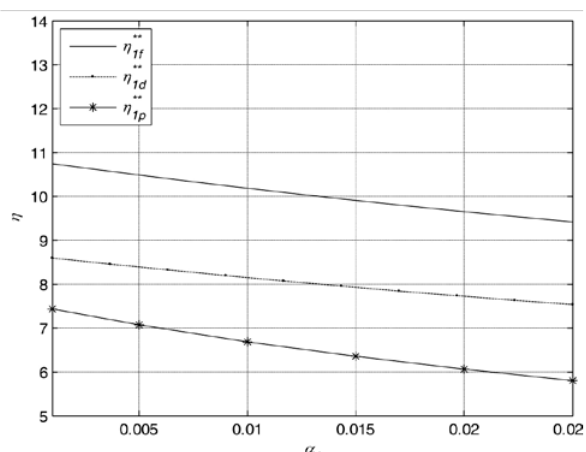
α on investment thresholds of agent 1 fig. 1. Impacts of 1 note: all the parameter values are set as follows: r = 0.05, I = 100, ρ = – 0.1, D (1) = 1, D (2) = 0.8, µ = 0.02, a